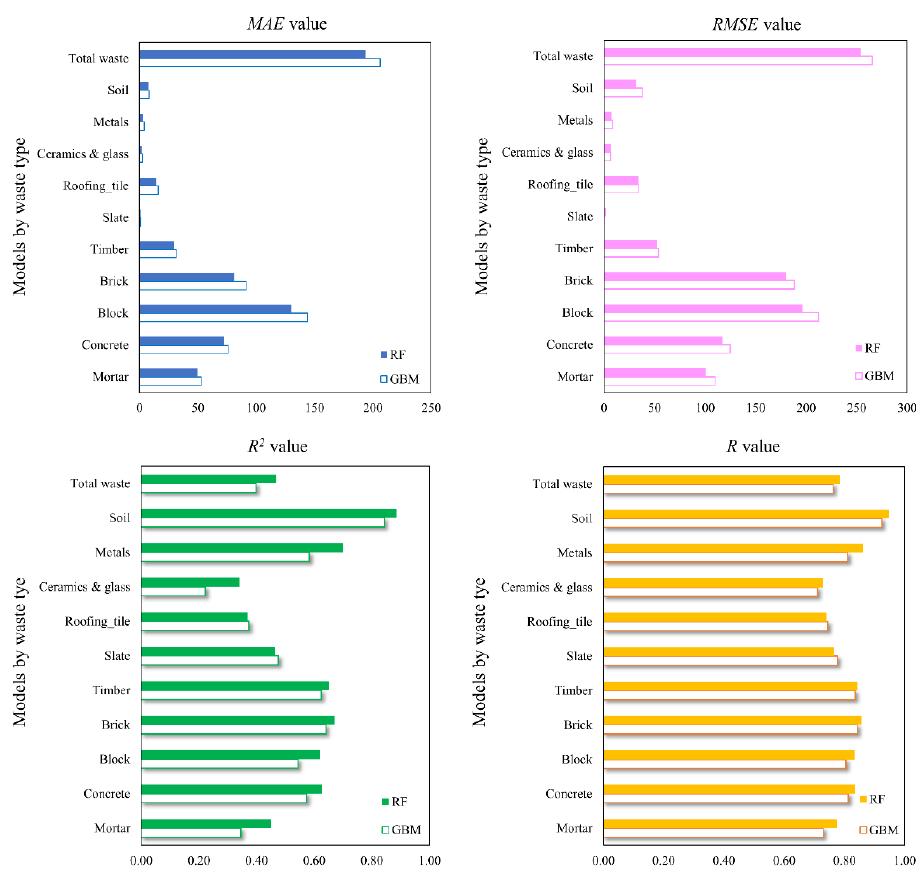
Figure 4. Comparison of statistical metrics ( MAE , RMSE , R 2 , R ) for GBM and RF models developed in this study. MAE , mean absolute error; RMSE , root mean square error; R 2 , coefficient of determination; R , Pearson’s correlation coefficient.